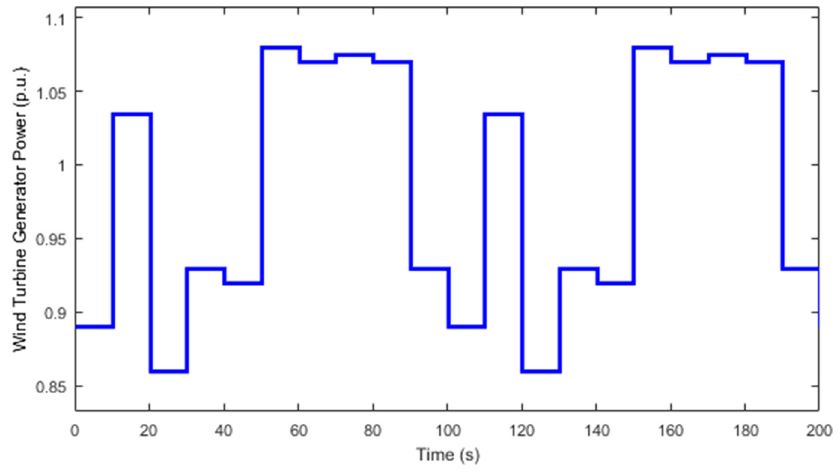
Figure 7. Wind turbine generator output power